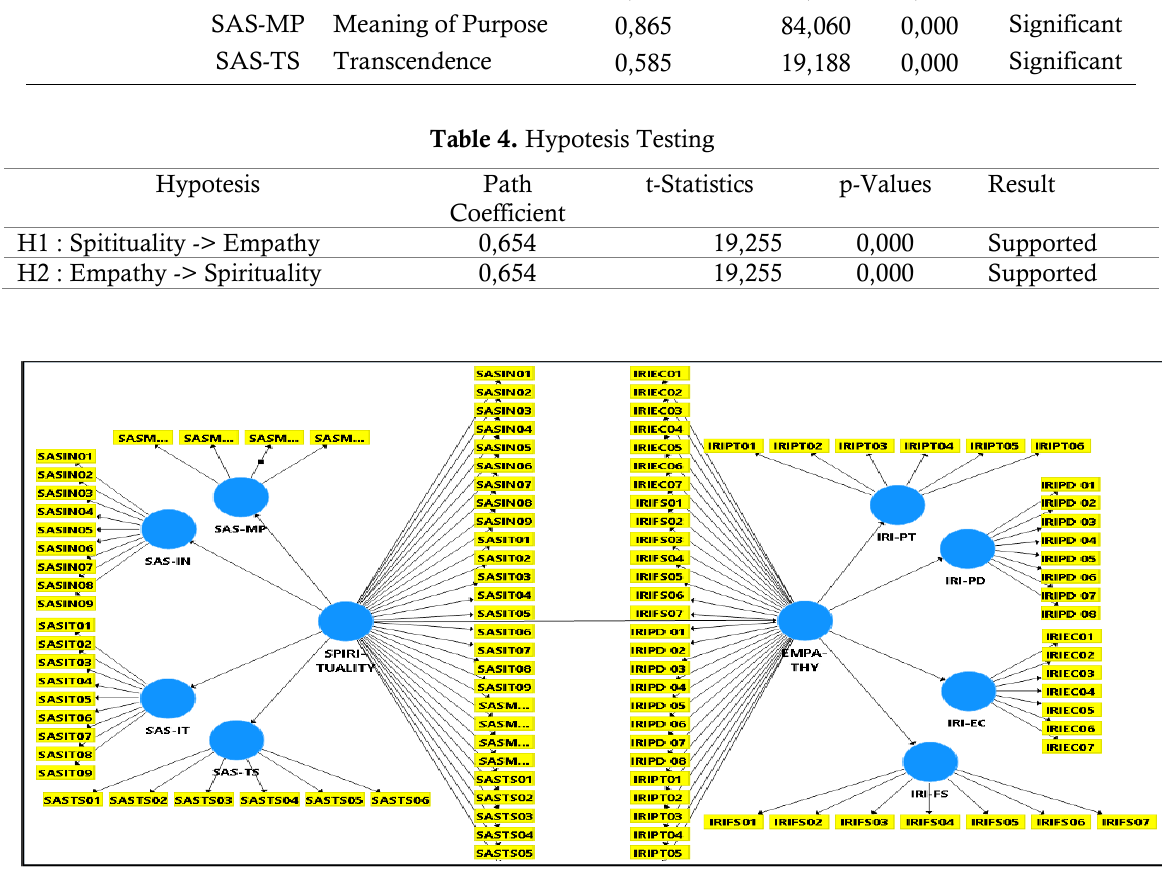
Figure 1. Research